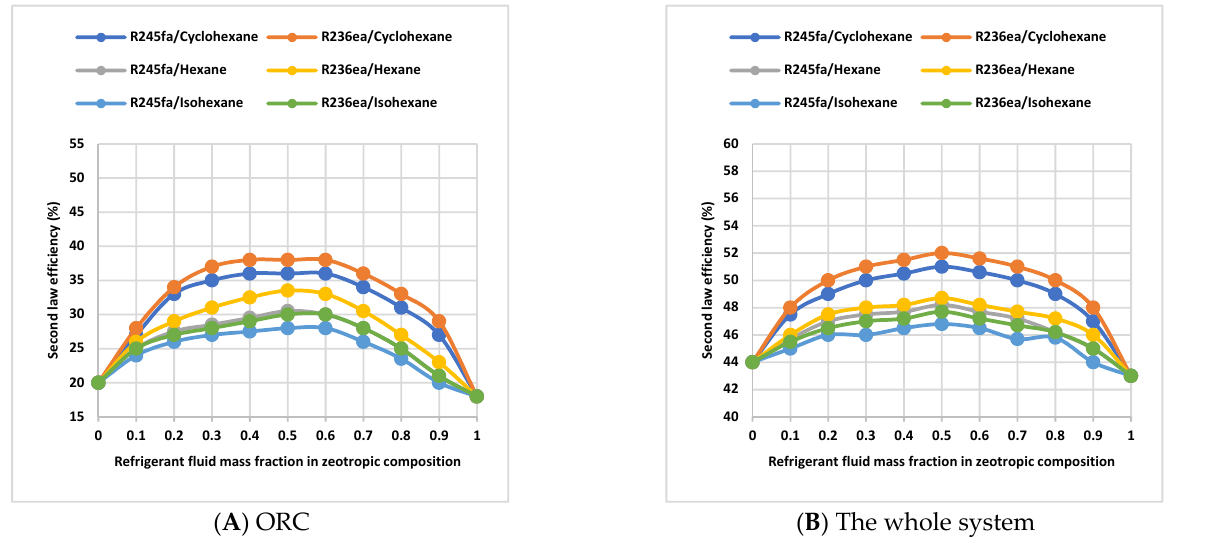
Figure 4. The efficiency of the second law of the whole system and the ORC to the mass fraction of refrigerants in the zeotropic composition.